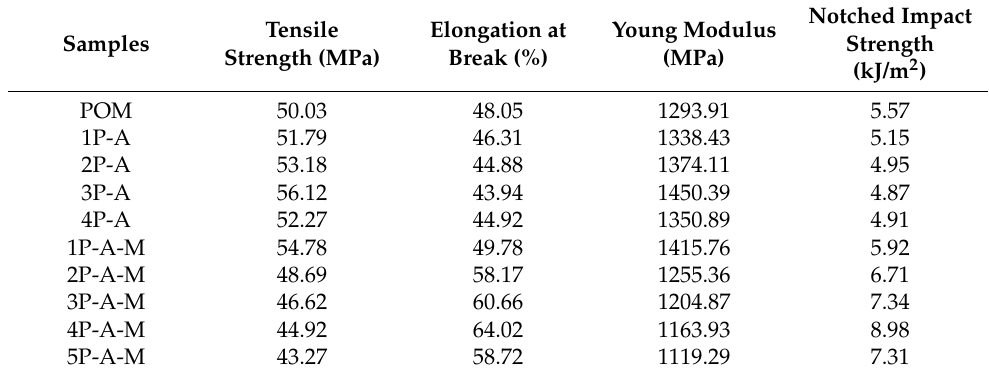
Table 3. Mechanical proper ties of POM/Ag nanocomposites and POM/Ag/MAH- g -POE ternary